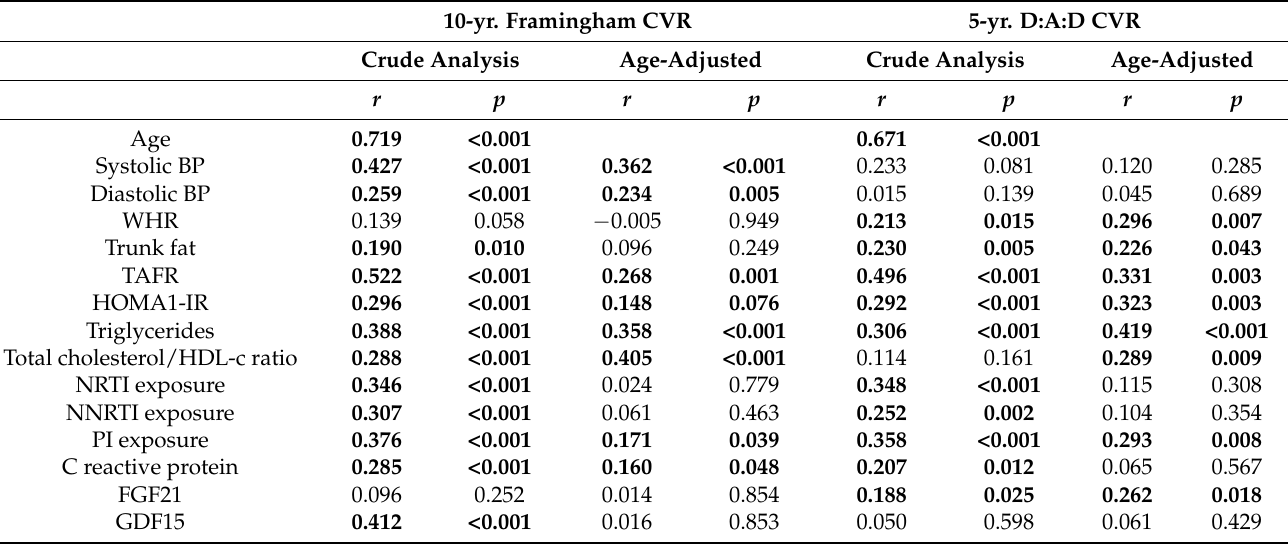
Table 4. Correlations of anthropometric, metabolic, infectious and treatment factors with cardiovas- cular risk scores (%) in